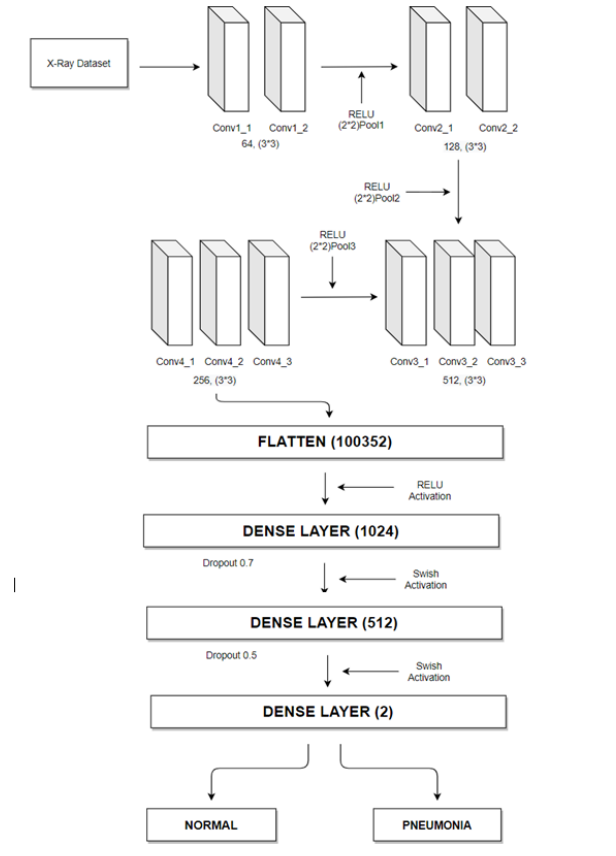
Figure 3. The proposed